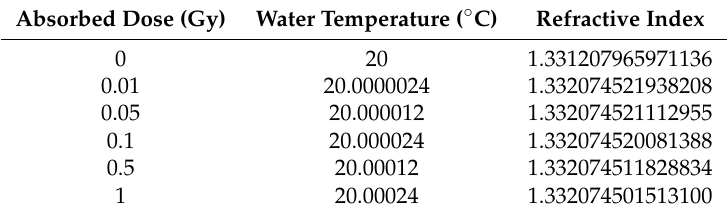
Table 1. Refractive index of water against different absorbed doses used in the test